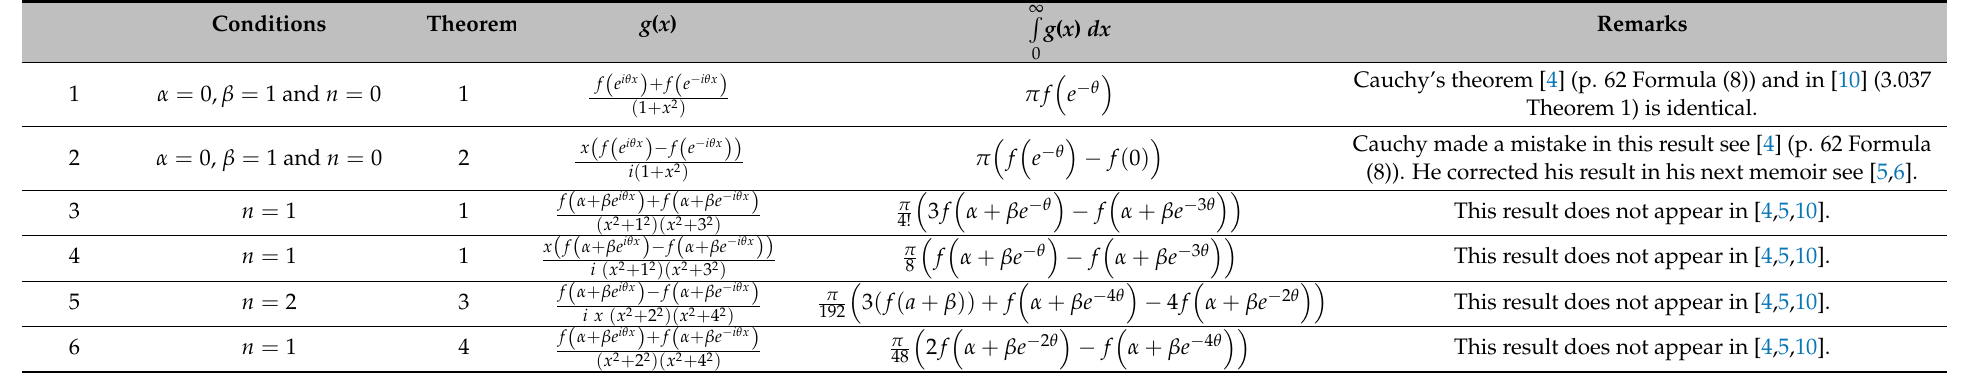
Table 2. Remarks on improper integrals, where θ >